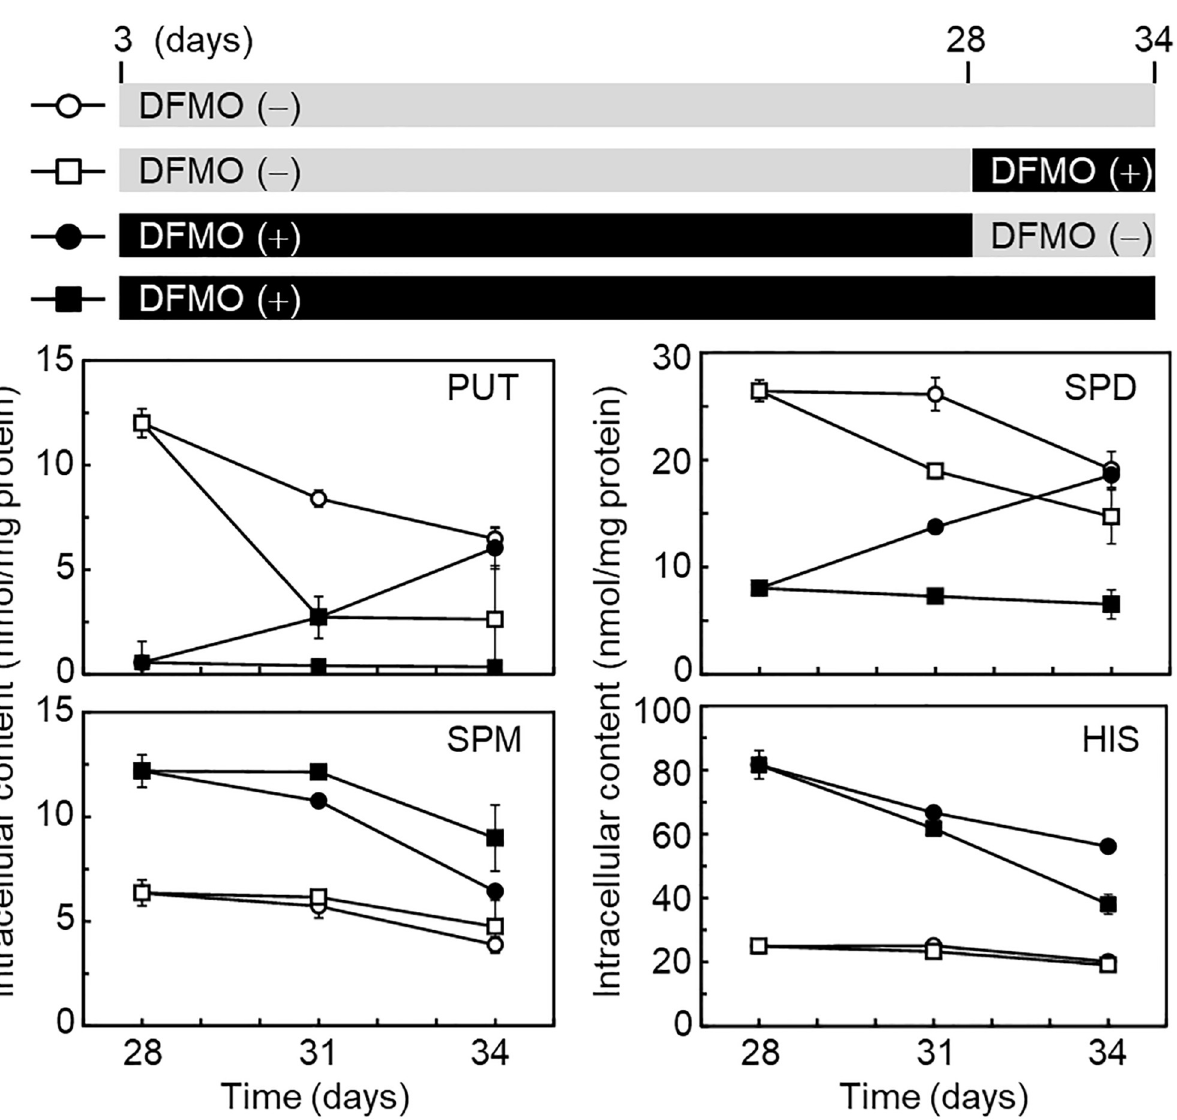
Fig 3. Effect of DFMO on the level of polyamines and histamine after BMMC differentiation. After 28 d of BMMC differentiation, in the absence or presence of DFMO, the cells were continuously cultured for 6 d under four different conditions, as shown in the upper panel. At each time point on day 28, 31, and 34, the level of polyamines and histamine was analyzed by HPLC. Mean ± s.d. is shown, n = 3